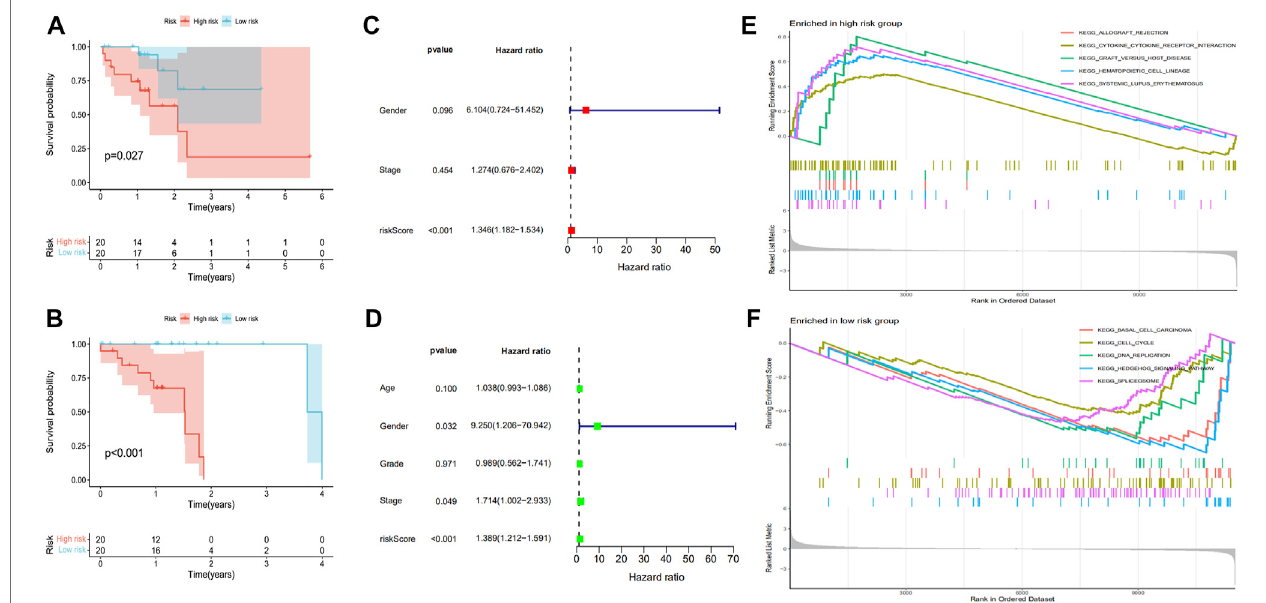
FIGURE 5 | Establishment of a prognostic risk model for ESCC. The Kaplan-Meier survival time was analyzed in the (A) training group and (B) test group. The independentprognosticanalysiswasanalyzed inthe (C) traininggroupand (D) test group. (E,F) showtheGSEAenrichmentbetweenthehigh-riskandlow-riskgroups.